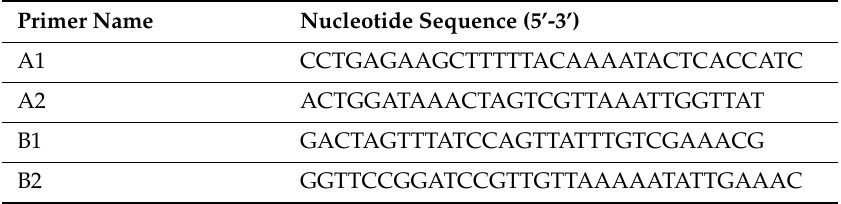
Table 1. Primers designed for oligonucleotide-directed mutagenesis in gene T5.026